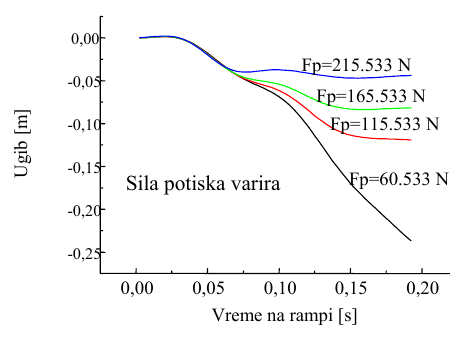
Sl. 13 – Simulacija procesa lansiranja za razli č ite vrednosti težine